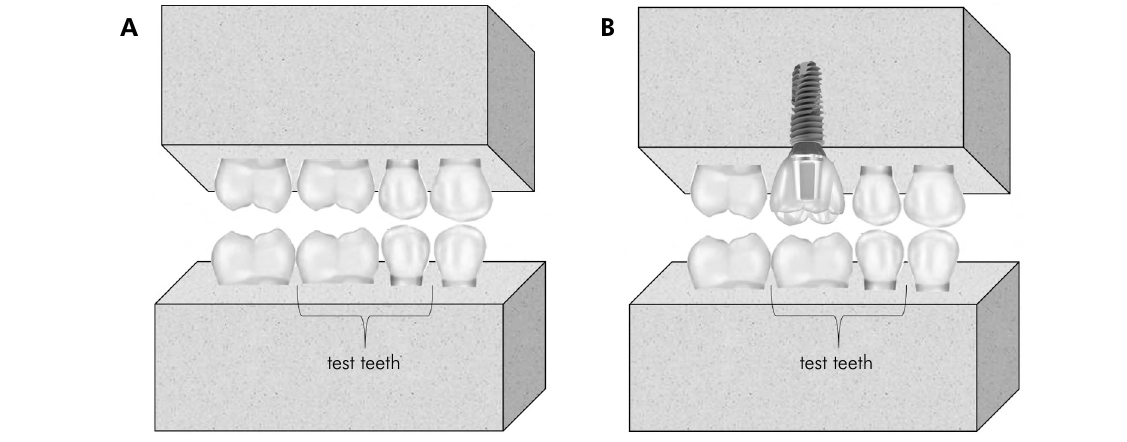
Figure 2. Schematic drawing of the radiographic phantoms indicating the pair of test teeth in the absence (A) and presence (B) of high-density